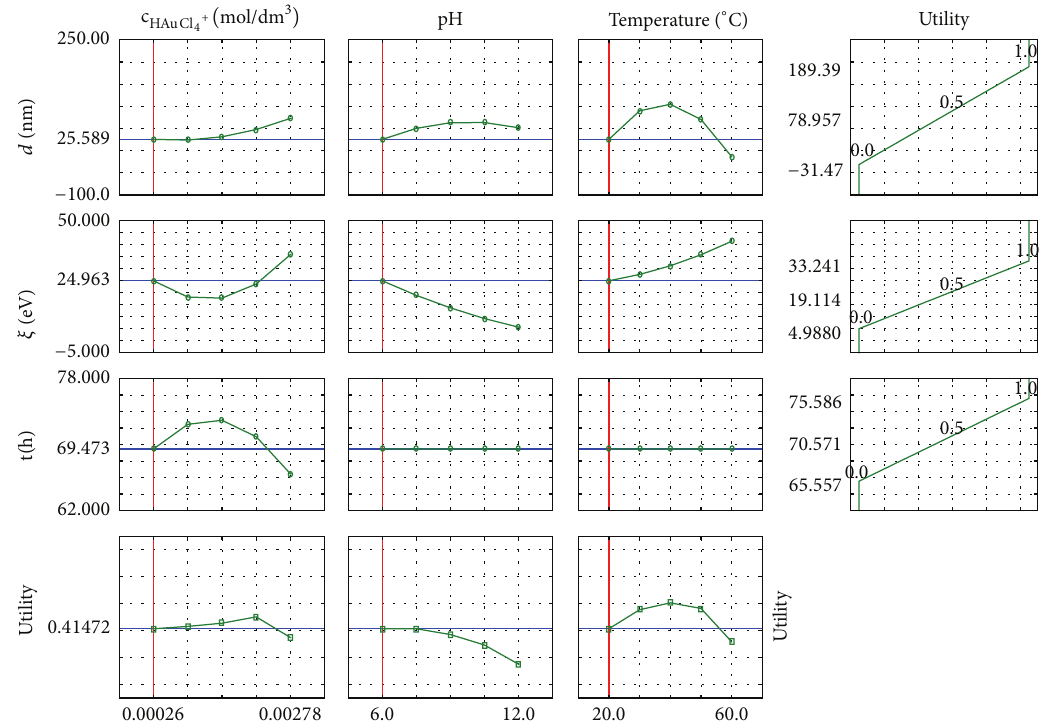
Figure 13: Response surface regression of output variables for nanogold suspensions obtained based on dog rose extract.